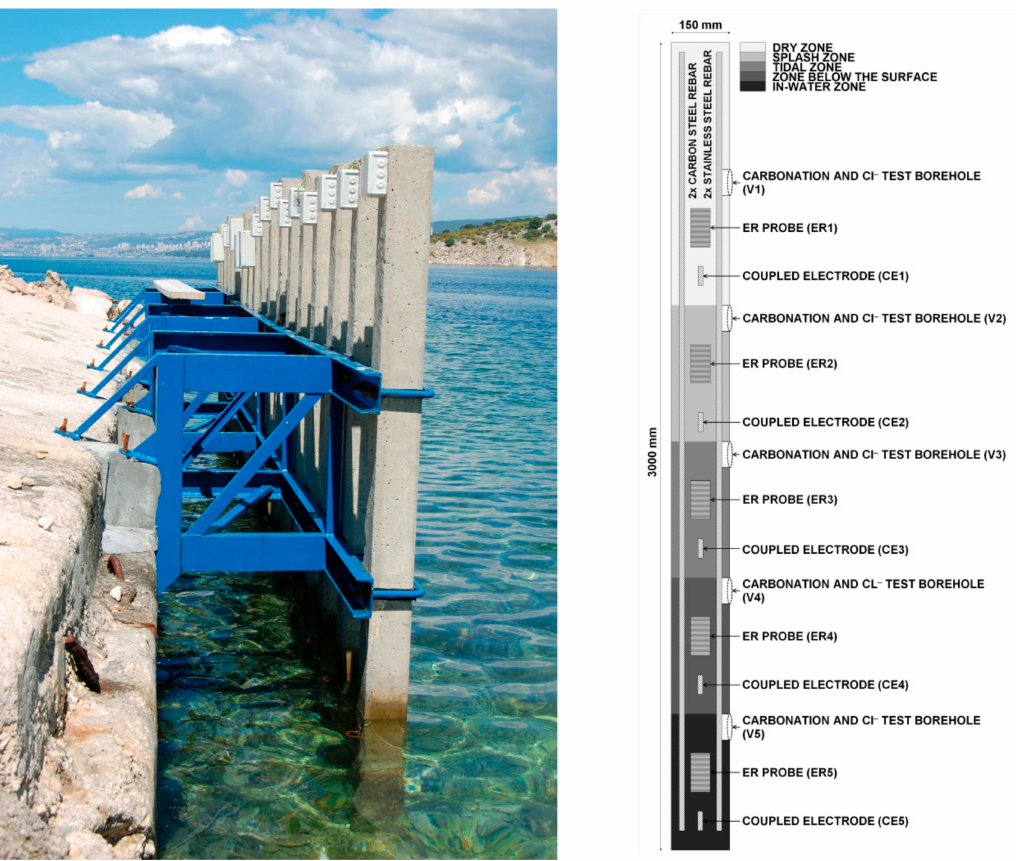
Figure 1. ( a ) Photograph and ( b ) schematic of a concrete column, placed vertically into the seawater, with the location of the steel reinforcement bars, electrical resistance (ER) probes, and coupled multi-electrodes (CMEs) at di ff erent heights (di ff erent exposure